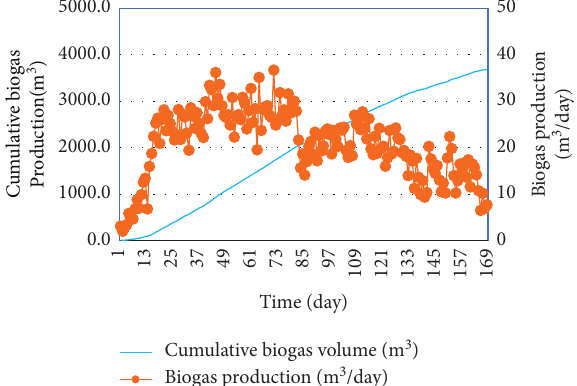
Figure 8: Biogas production and cumulative curve during an- aerobic digestion in the pilot-scale MBBR.